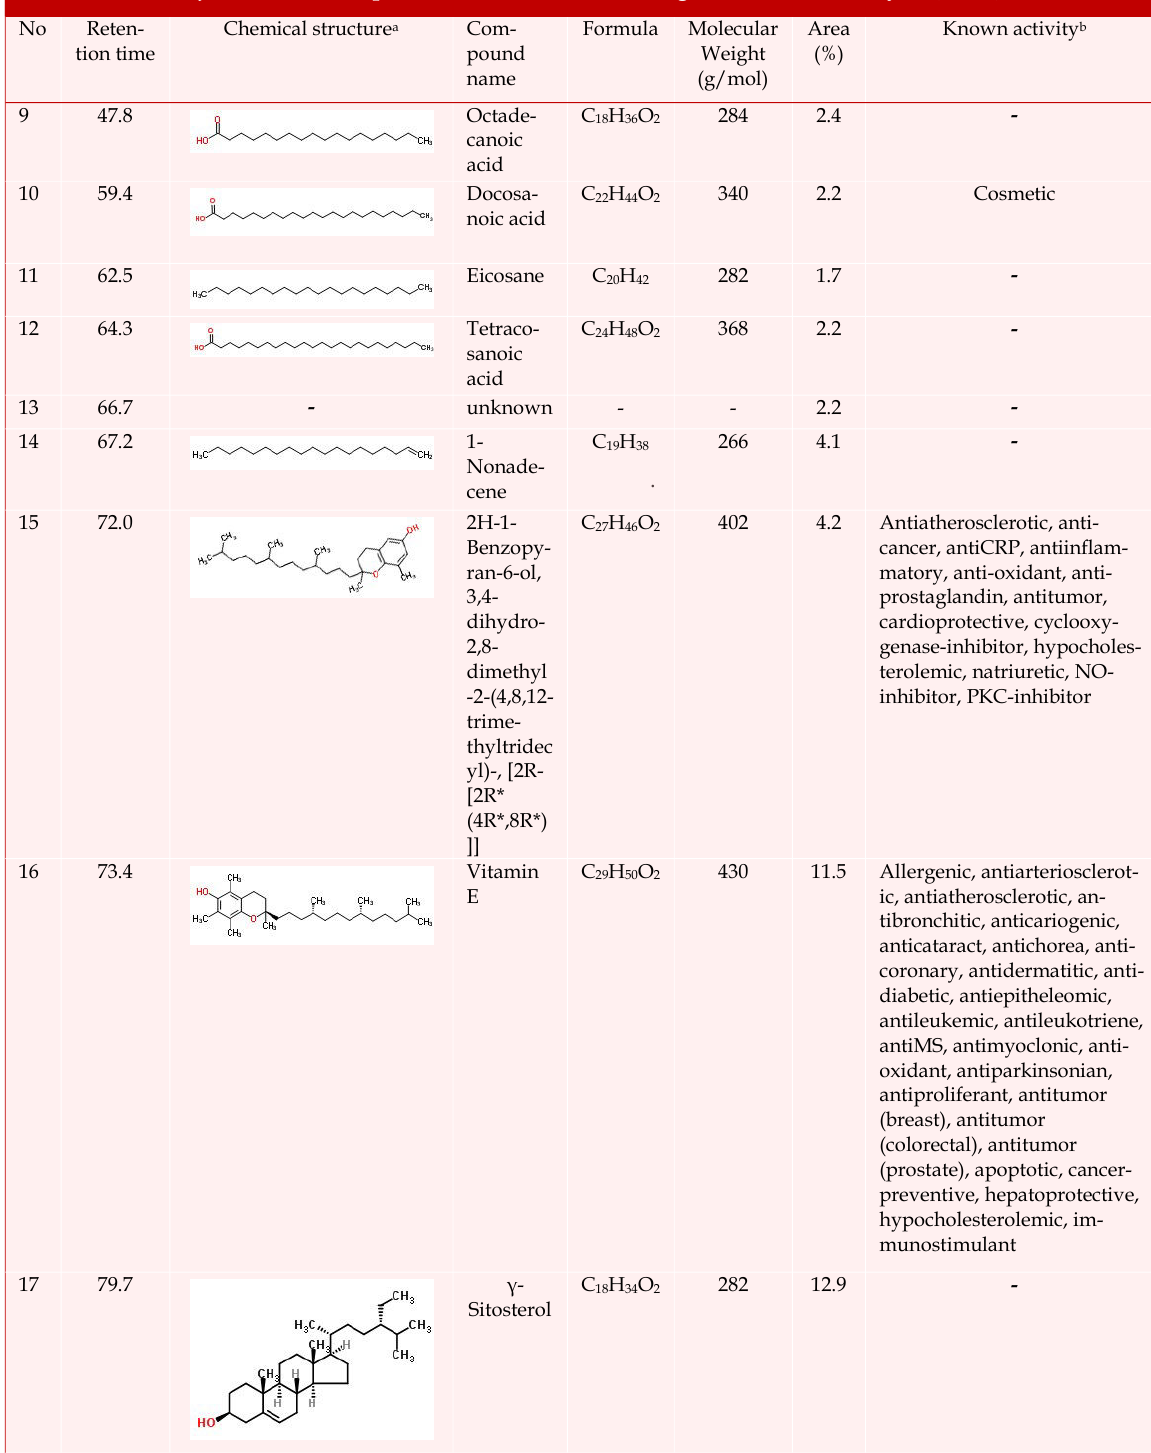
Major chemical components of F. hirsuta according to the GC-MS analysis